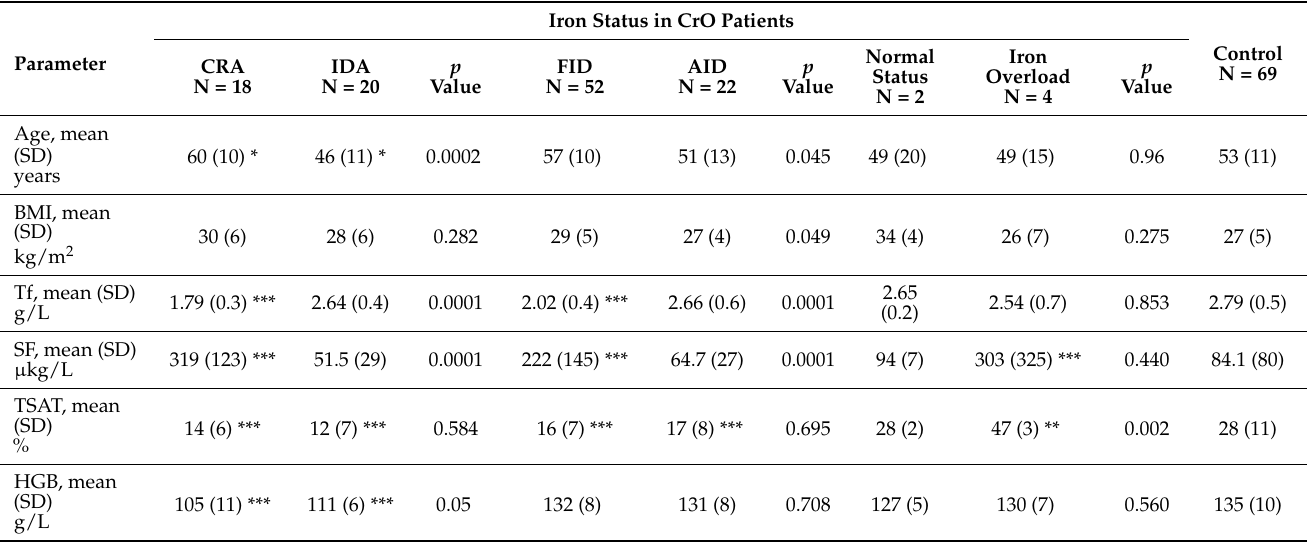
were observed in patients with associated AID ( p < 0.0001) or IDA ( p < 0.0001) and in those